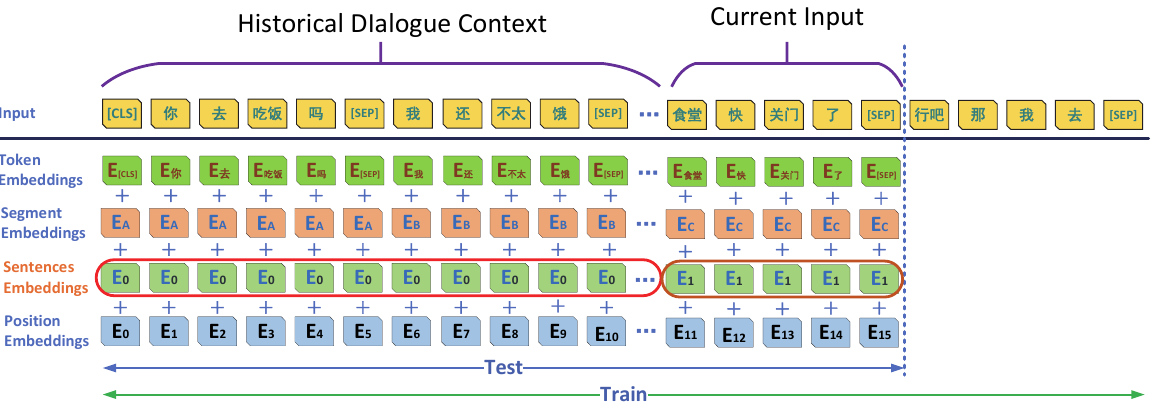
Figure 1. Context Encoding Structure of the PBTG Model.